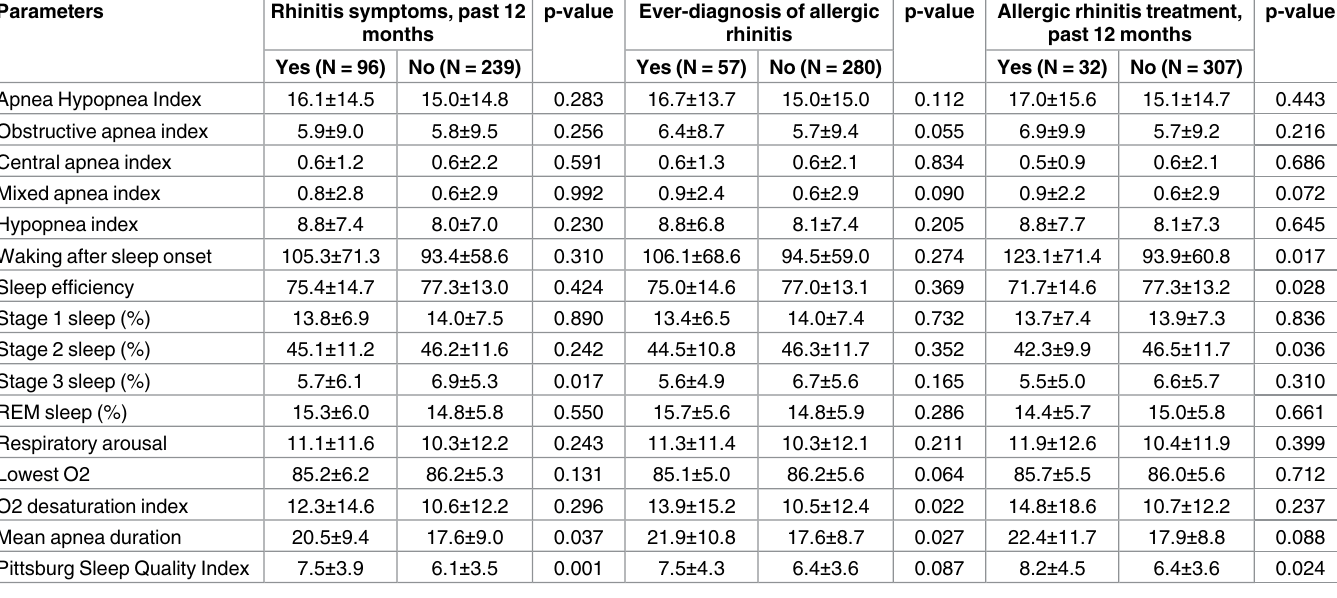
Table 4. Sleep parameters in polysomnography and sleep quality index according to co-morbidity of allergic rhinitis.